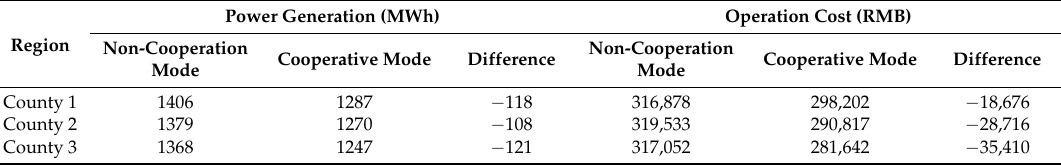
Table 1. Power production and operation costs of thermal power.